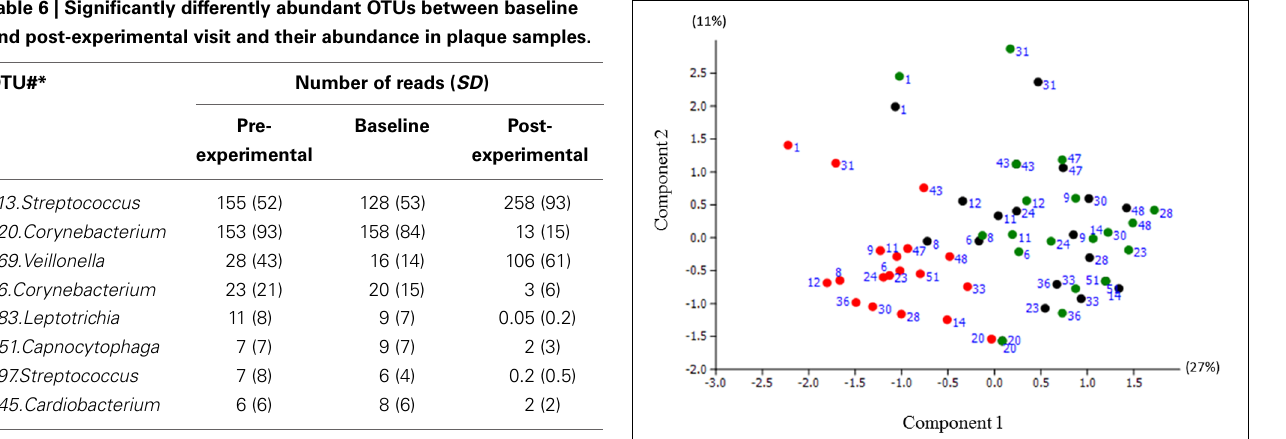
FIGURE 4 | Principal Component Analysis (PCA) plot of microbiome samples from pre-experimental visit (black dots); baseline of the experimental period (green dots) and post-experimental visit (red dots). The first component (PC1) explained 27% of the total variance, the PC2—11%. The same labels indicate samples that originated from the same